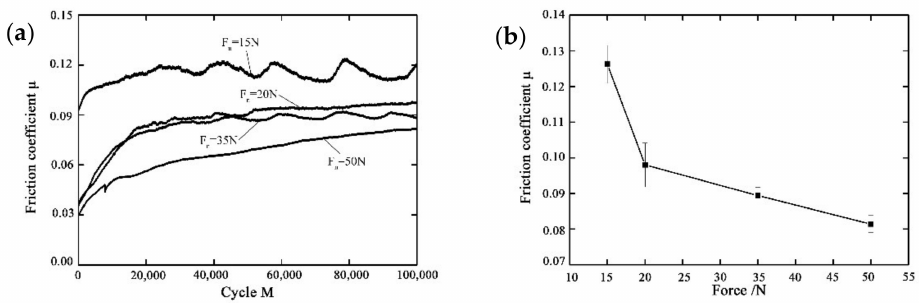
Figure 9. The effect of the normal force on the friction coefficient of PVDF thin films with with D = ± 20 µ m, ƒ = 15 Hz, and V c = 0 V: ( a ) variation with the number of cycles, ( b ) error bar.